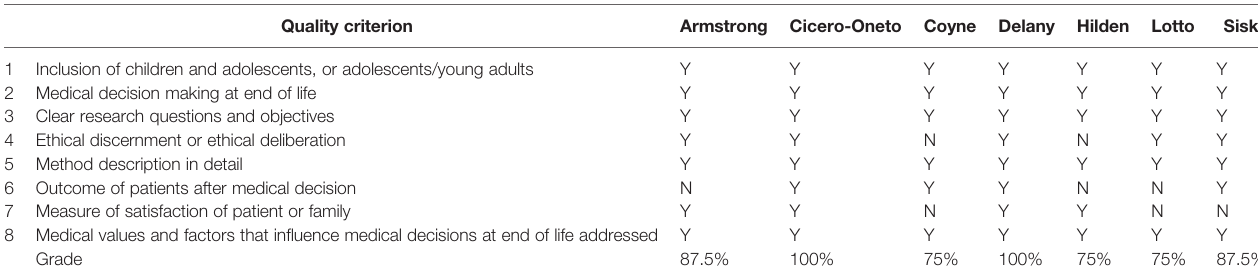
TABLE 2 | Criteria used to appraise study